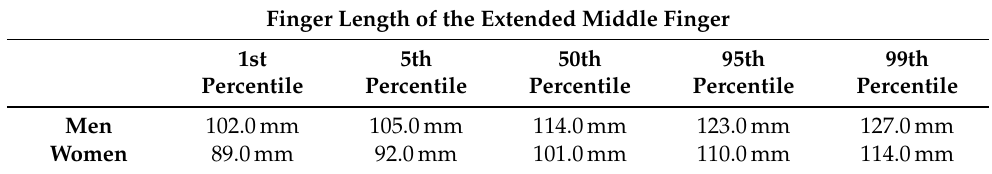
Table A1. Finger length of the extended middle finger for men and women, according to [46].